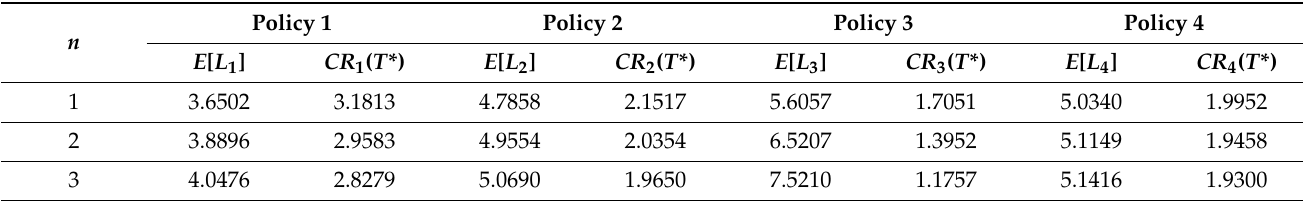
Table 2. Comparison of different policies.